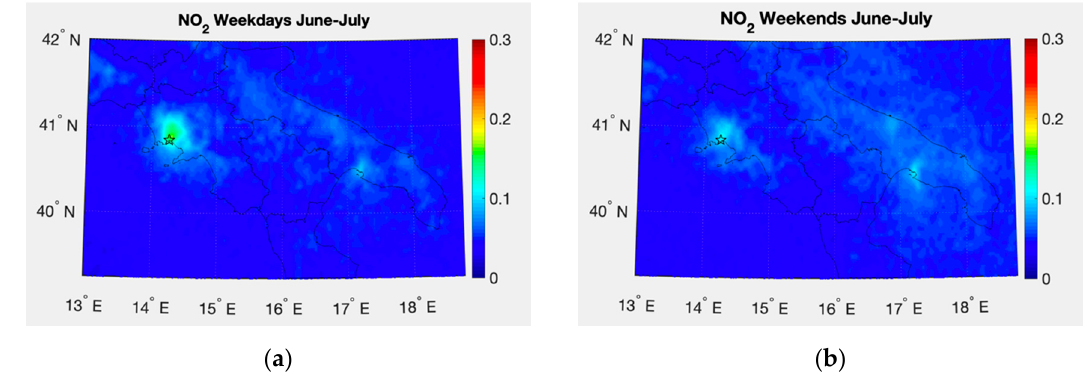
Figure 15. Level 3 NO 2 tropospheric column data over Southern Italy for ( a ) 16 weekdays in June–July and ( b ) 16 weekends in the same period. The star indicates the city of Naples.